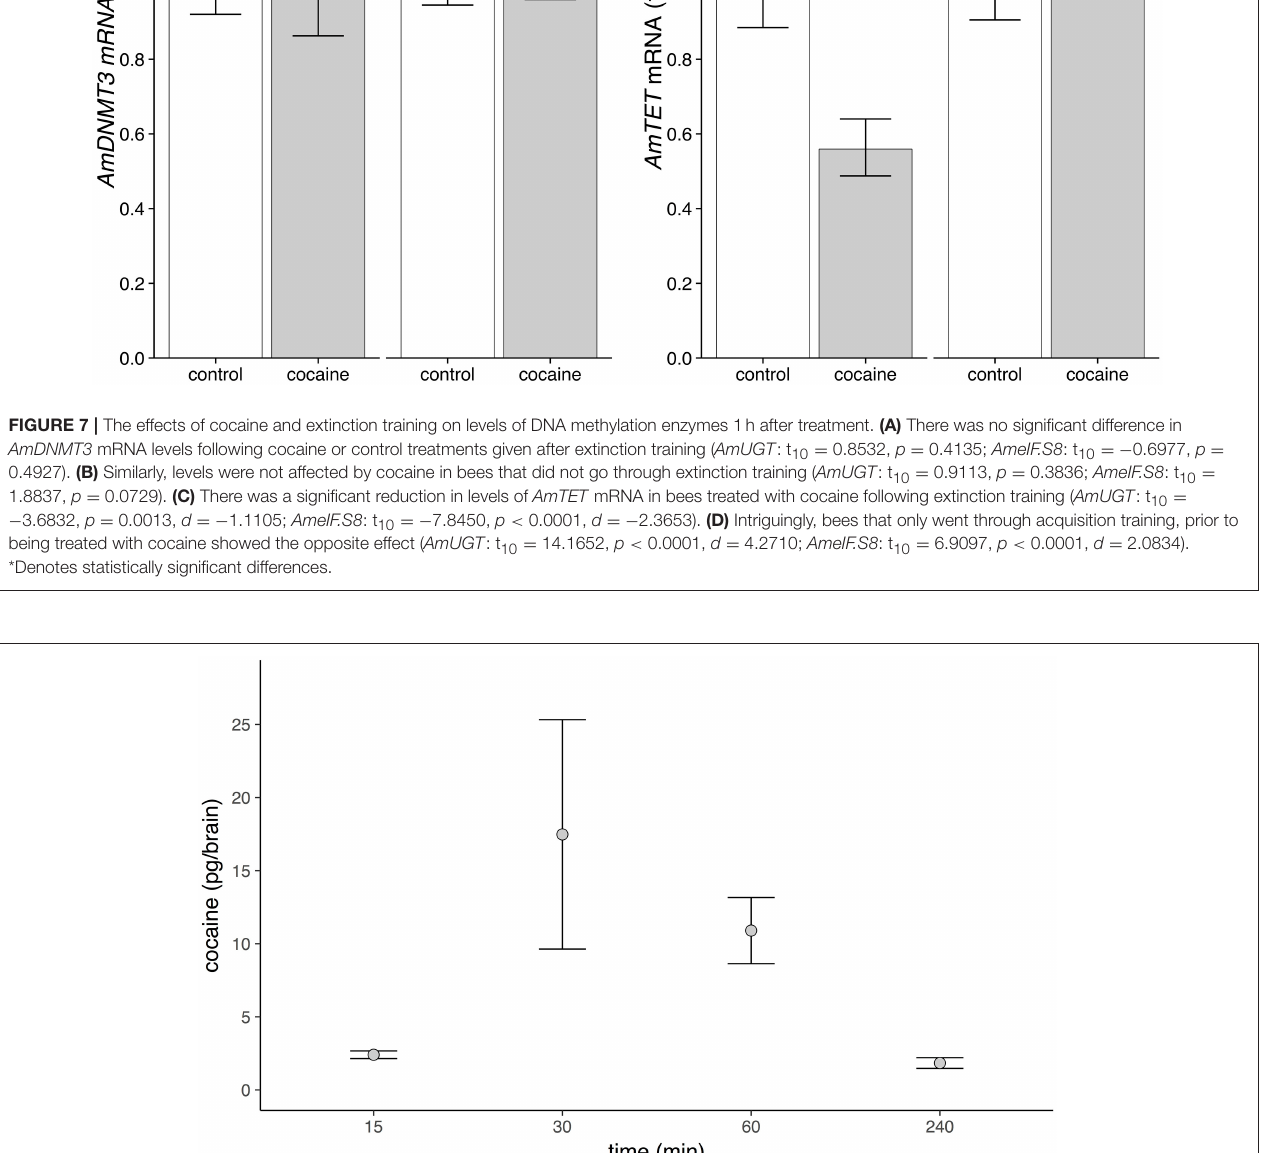
Frontiers in Physiology |